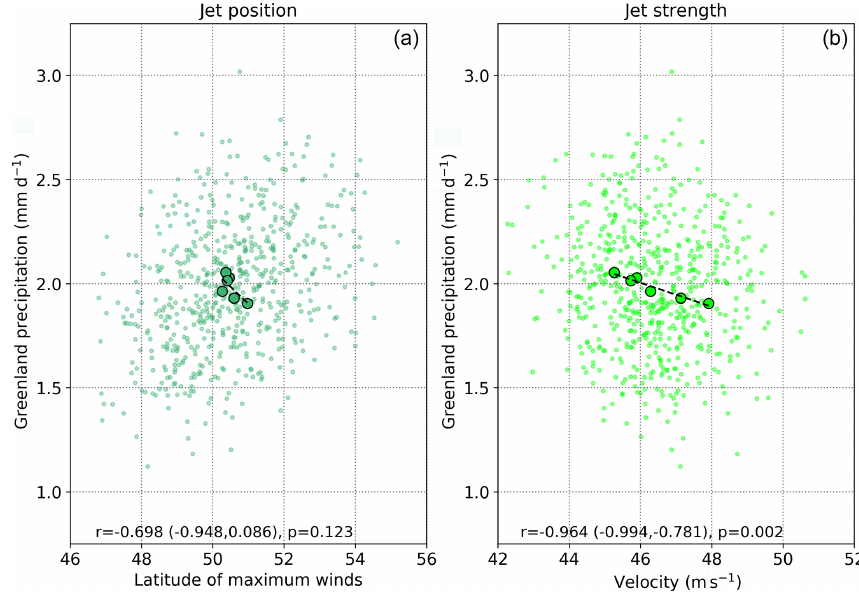
Figure 9. Relationships between JJA-mean latitude of maximum 300hPa winds (a) , the magnitude of the maximum jet wind (b) , and seasonal-mean precipitation over Greenland (land-only). As with eddy heat fluxes, the correlation is only significant for jet strength.